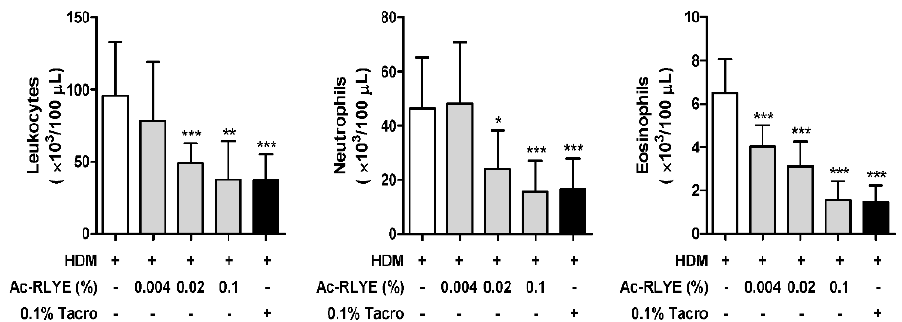
Figure 4. Ac-RLYE reduces immune cell infiltrations. Blood samples were analyzed using differential cell counting. Data are presented as mean ± SD values for each group ( n = 10). * p < 0.05, ** p < 0.01, *** p < 0.0001 in comparison to vehicle-treated group.